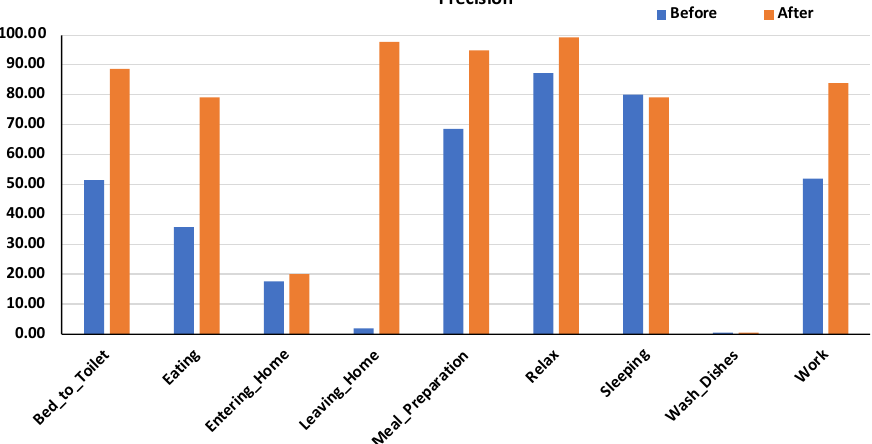
Figure 11. Comparison of precision values of paradigm #3 before and after applying semantic preprocessing. Burst improvements are achieved with almost all activities, since a considerable source of confusion has been got rid